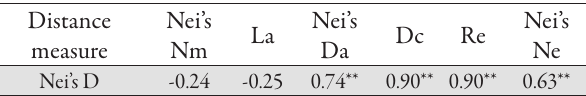
Tab. 3. Correlation coefficients of Nei’s D with other genetic